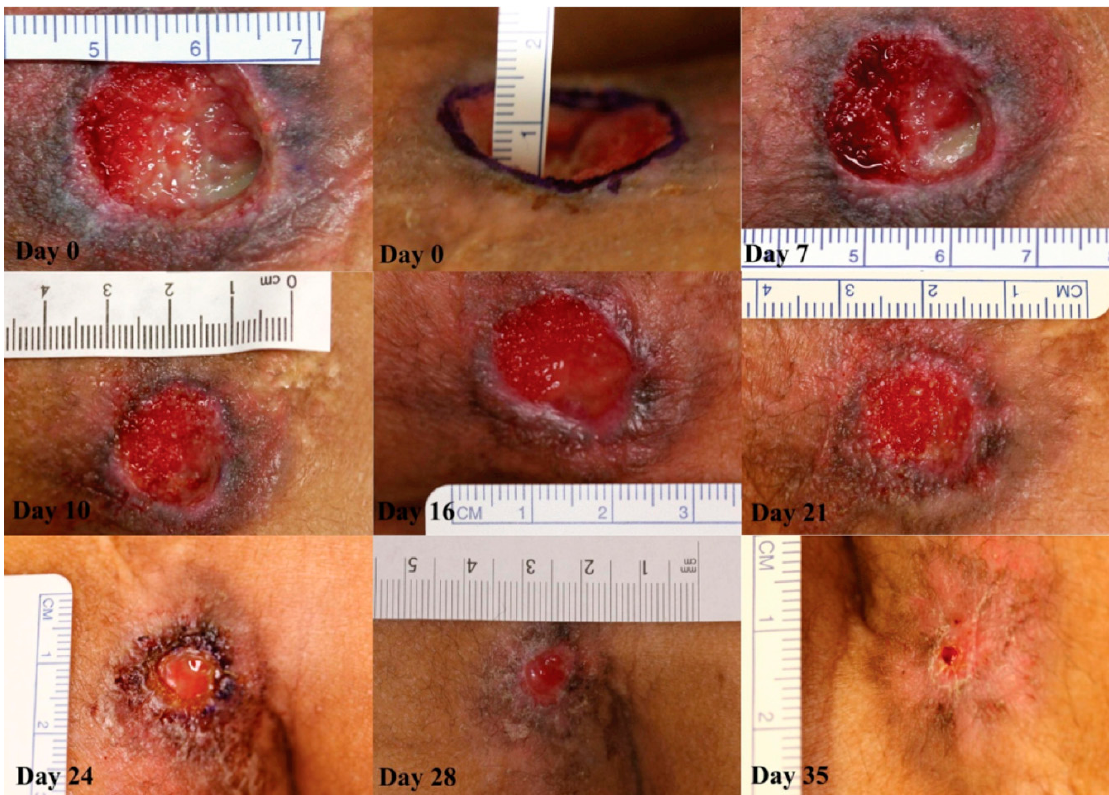
Figure 4. Case 1: sacral pressure ulcer progression through healing after activated protein C (APC) administration. On day 0, the wound had a central depth of 10 mm. At day 7, the wound was 20 mm in diameter. Rapid growth of granulation tissue is apparent from day 7 to day 16. At day 16, the diameter was 18 mm. On day 21, the diameter was 14 mm, and by day 24 the wound was 6 mm in diameter. Therapy was stopped at this point. At day 28, the diameter was 5 mm. Final follow-up at day 35 showed that the wound had healed completely. No images of the follow-up. © 2014 The Authors. International Wound Journal © 2014 Medicalhelplines.com Inc and John Wiley & Sons Ltd. Reproduced with permission. License number 4525880595450.